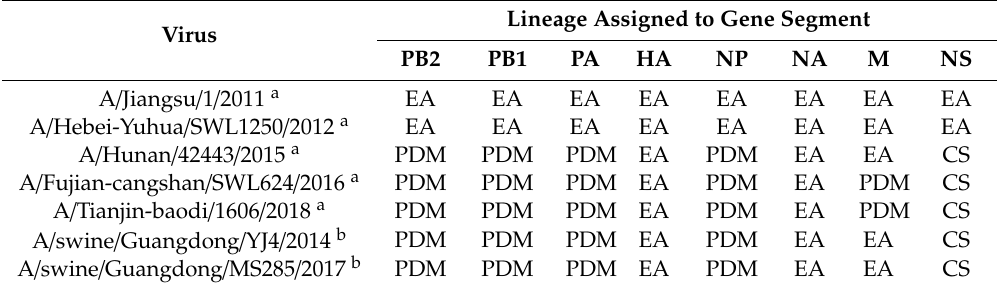
Table 1. Table 1. Phylogenetic analyses of A / swine / Guangdong / YJ4 / 2014 and A / swine / Guangdong / MS285 / 2017. Virus